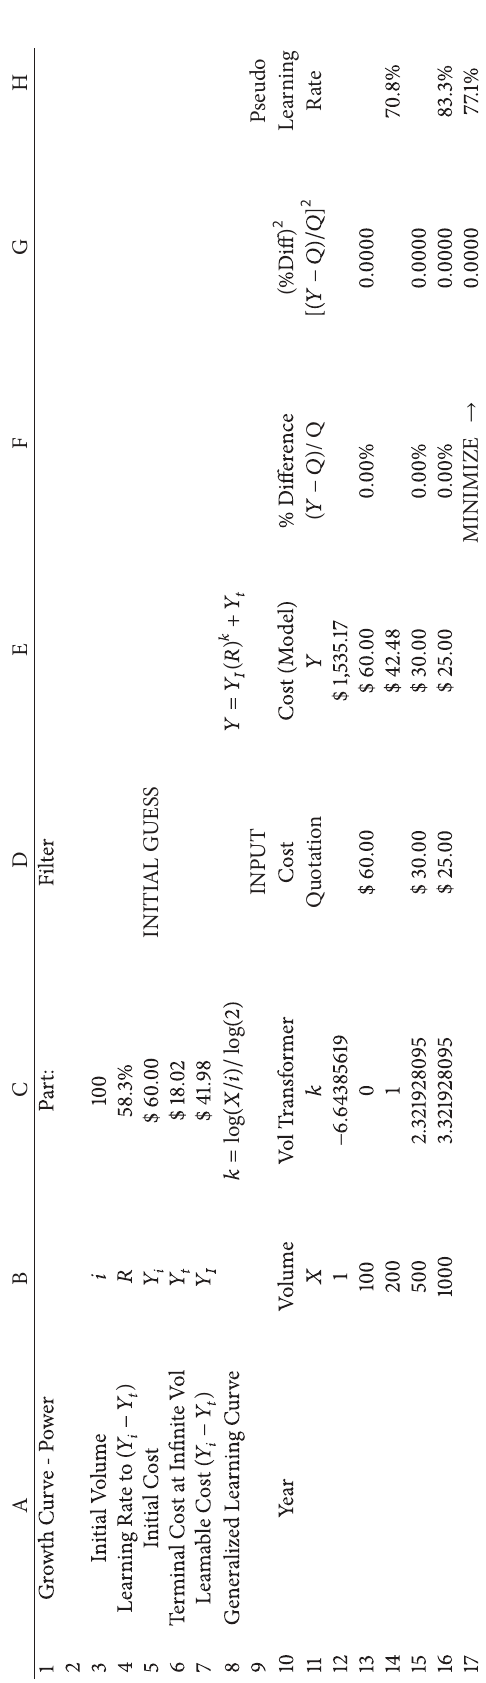
Figure 2: Model summary for